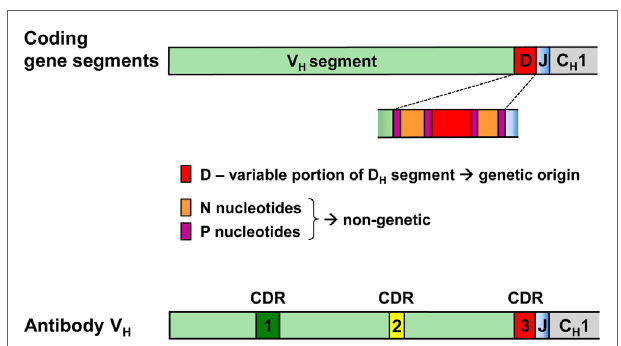
FiGURe 2 | VDJ gene segments coding for the antibody heavy chain variable region and modifications creating the third complementarity-determining region CDR-H3 of antibodies. CDR-H1 and CDR-H2 are fully encoded in the genomic V H gene segment. By contrast, CDR-H3 coding sequences are somatically created during recombination of V, D, and J gene segments. During this process, all three segments can be modified by deletion of nucleotides through exonuclease activity, addition of P nucleotides and insertion of N-nucleotides at the two junctions by terminal deoxynucleotidyl transferase. Hence, the D-region in the middle of CDR-H3 does not conform to genomic sequences and may be flanked by non-genetic N/P sequences that do not have an inheritable genomic